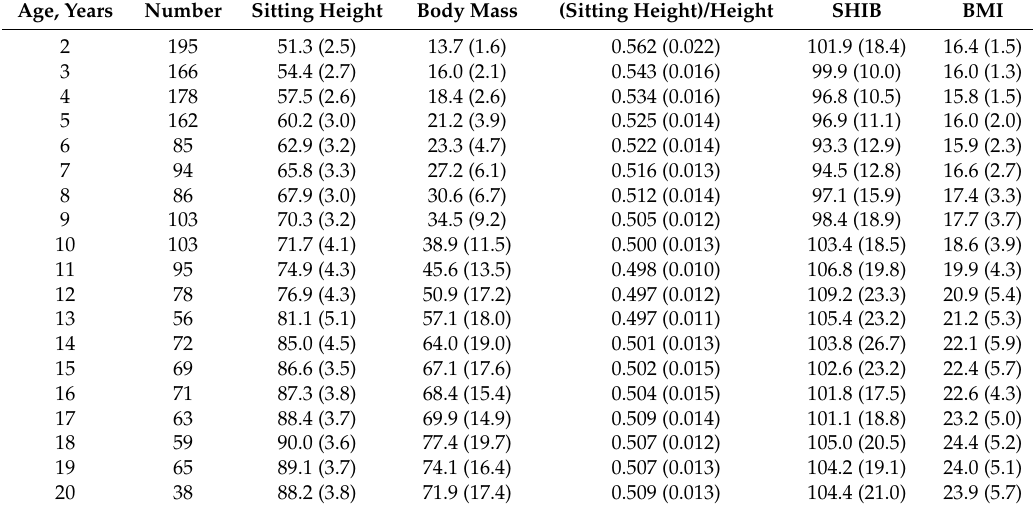
Table 3. Sample sizes and means (with standard deviations in brackets) of sitting height (cm), body mass (kg), ratio of sitting height to standing height, sitting-height index of build (SHIB, kg/m 3 ) and body mass index (BMI, kg/m 2 ) of black males. The data are from the NHANES III laboratory data file [15].